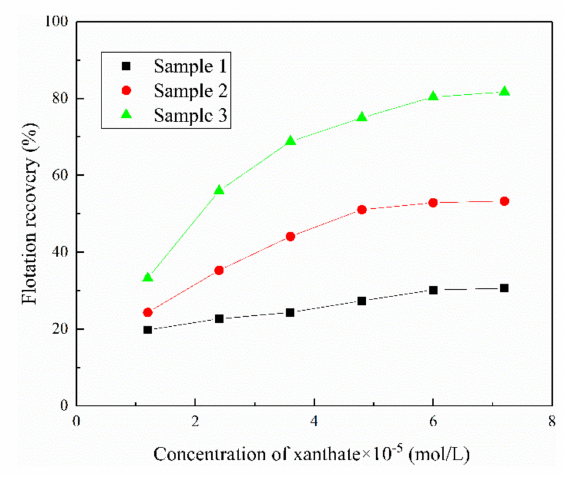
Figure 3. Flotation recovery of three samples as a function of the xanthate concentration (pH =